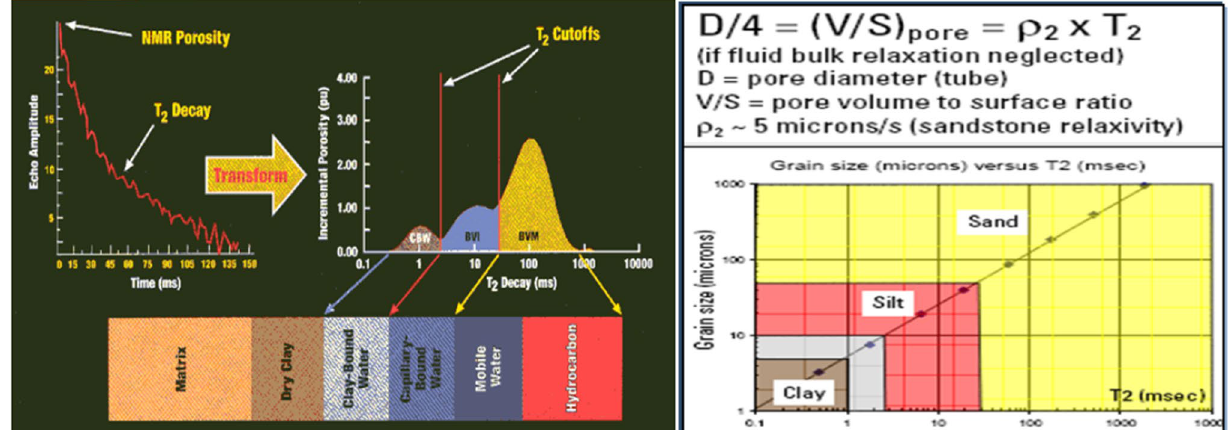
Fig. 4 NMR T 2 cut off between clay, silt, and